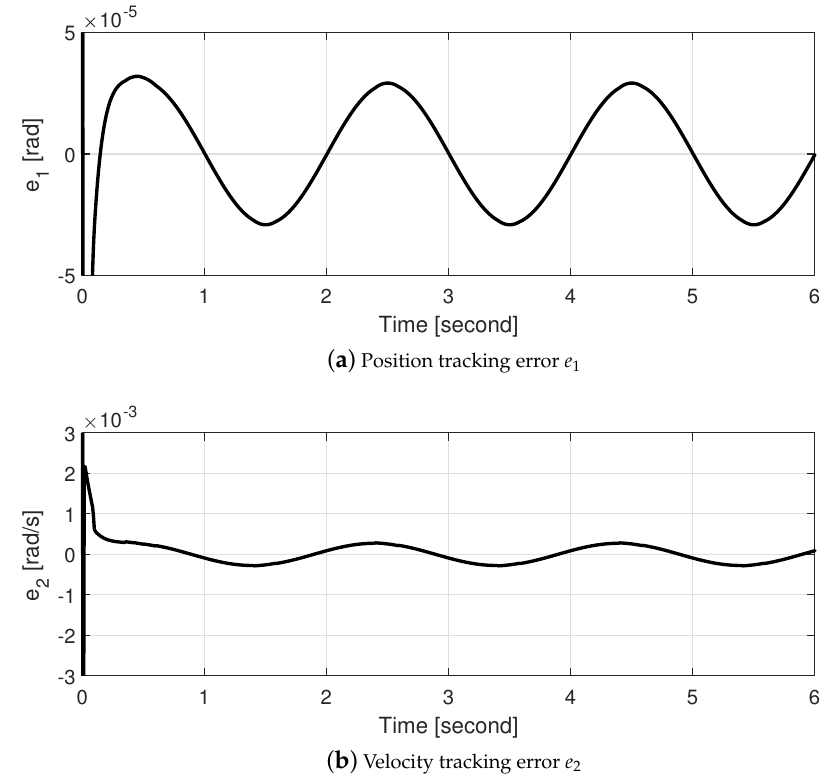
Figure 4. Position and velocity tracking errors of the PI